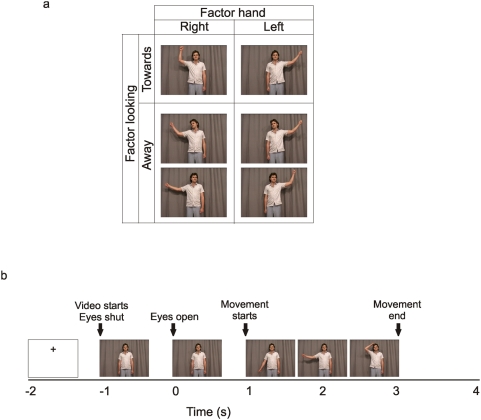
Experimental design.Figure 1a stills from the videos of experiment 1 showing the 2×2 factorial design collapsed across the factors goal and eye gaze direction. The factors depicted here are hand moved and the head position. Figure 1b shows the time course of a typical trial.